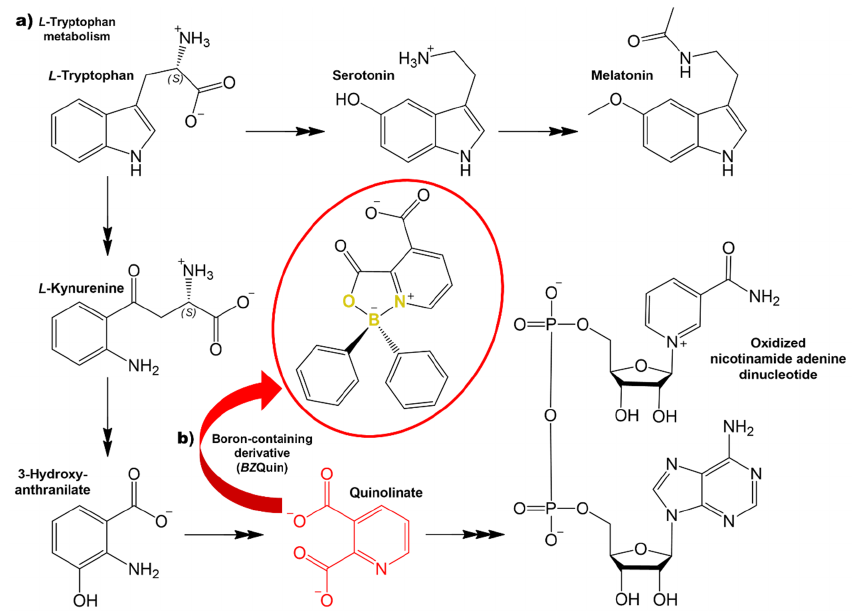
Figure 1. ( a ) L ‐ Tryptophan metabolism: canonical pathway and kynurenine pathway. ( b ) BZQuin (yellow) heteroatoms forming a five ‐ member heterocycle. The chemical structures are represented considering the protonation and deprotonation of their groups at physiological pH (7.4).